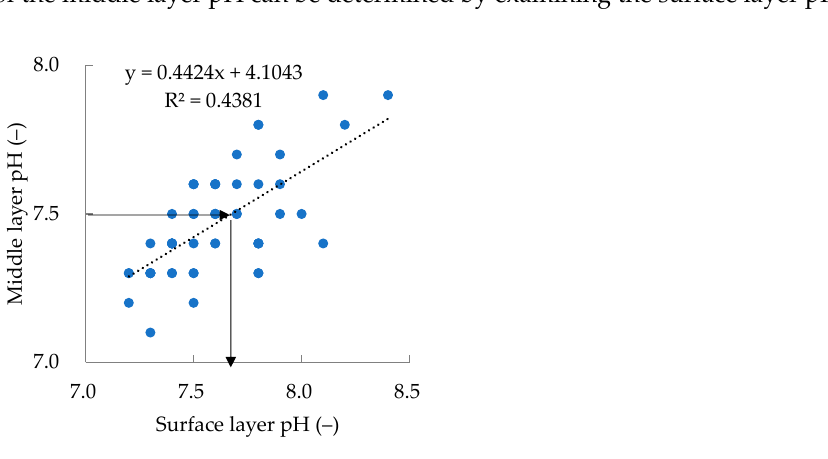
( b ) Figure 2. Average pH of Sankyo RRR: ( a ) seasonal trend (2012–2020); ( b ) secular trend; error bar: SD. The secular trend of pH in the surface and middle layers from 2012 to 2020 is shown in Figure 2b. The pH of the surface layer is higher than that of the middle layer. The pH of the middle layer is almost near the upper limit of the agreed value. No significant sec-